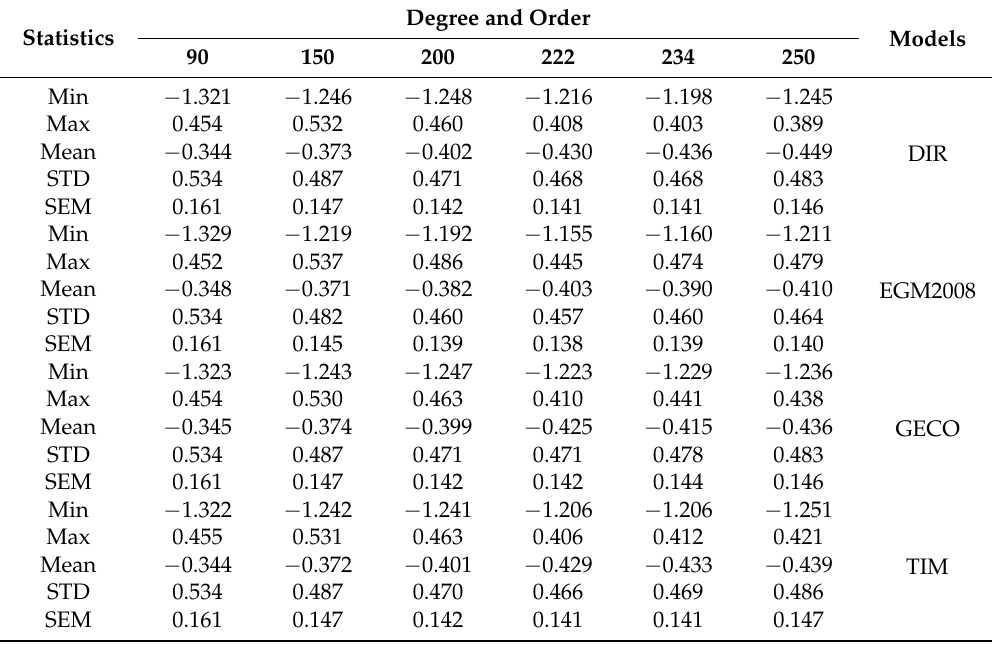
Table 2. Statistics of absolute validation of gravimetric geoid models using GPS/trigonometric data (m). Degree and Statistics